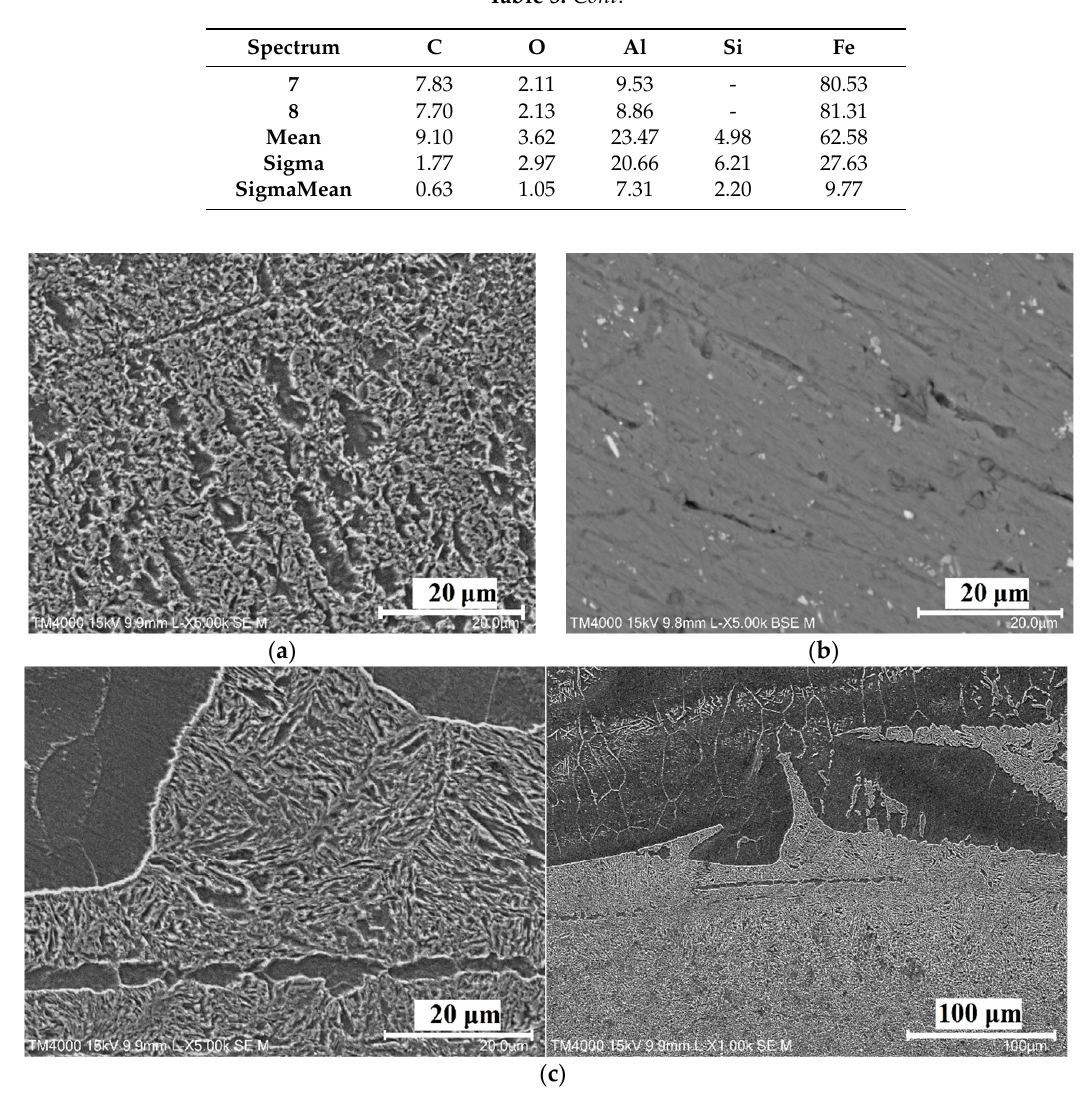
Figure 14. Scanning electron microscope (SEM) observations: ( a ) Steel; ( b ) Aluminum; ( c ) Steel–aluminum joint interfaces.